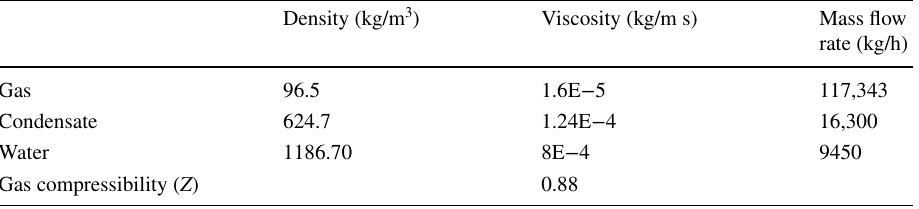
Table 2 Flow rates and physical properties of